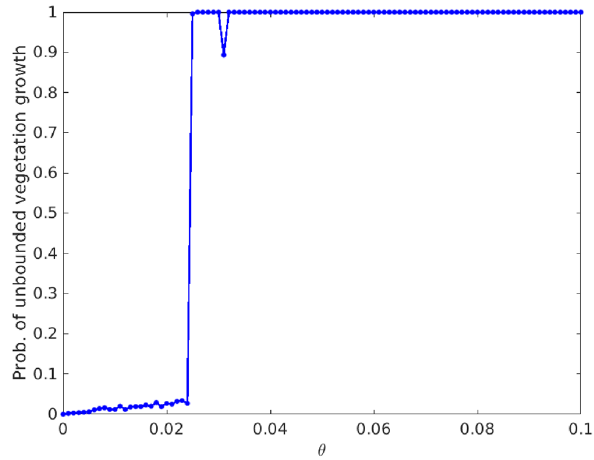
Figure 1. Probability of unbounded growth of the vegetation population ( u ) with respect to θ . Here an explosive blow-up is considered to have occurred when the vegetation population exceeds a value of 10 3 . The probability is estimated from a sample of 10 3 initial states randomly distributed in a hyper-cube ( u ∈ [ 0 : 4 ] , v ∈ [ 0 : 2 ] , w ∈ [ 0 : 5 ] ) in phase space. Interestingly, the slight dip in the estimated probability of unbounded growth in the narrow window around θ ∼ 0.031 arises from unbounded orbits co-existing with a small set of initial states that evolve to bounded periodic